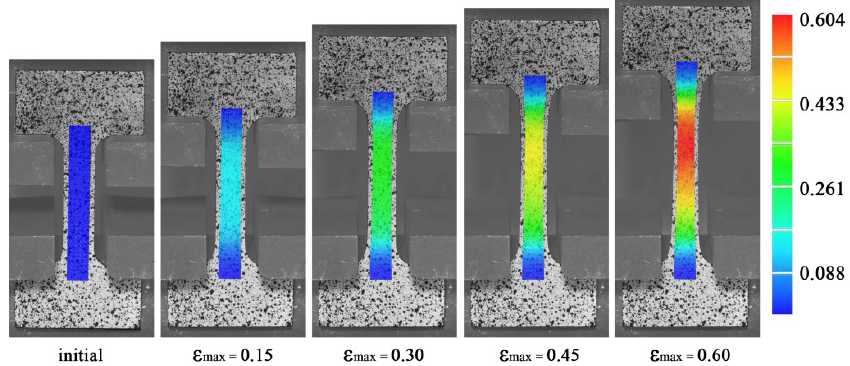
Figure 3. Axial strain maps for different deformation stage at 90 mm/min crosshead speed.